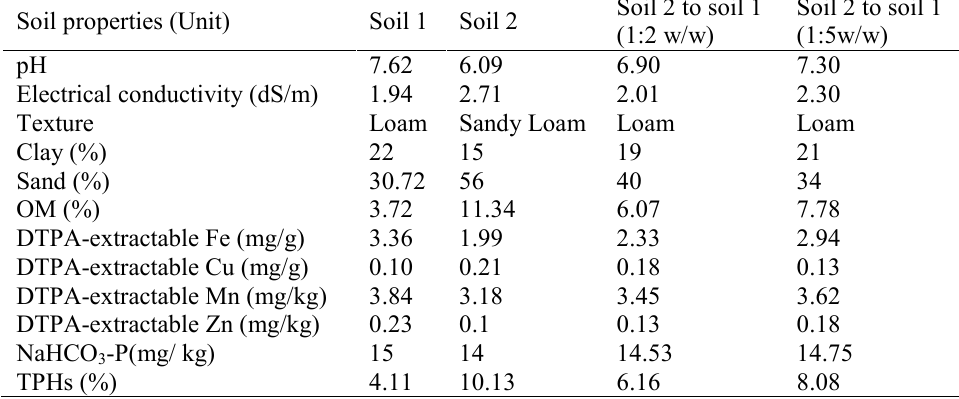
Table 1. Selected chemical and physical properties of soil samples Soil properties (Unit)